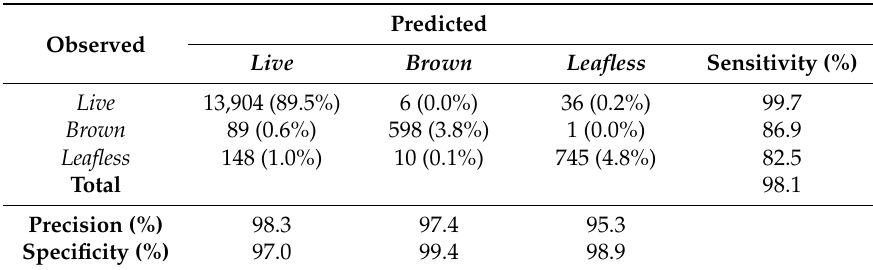
Table 3. Confusion matrix of the cross-validation procedure for the chosen value of likelihood threshold ( T = 0.65 ) for the decision rule on the combined